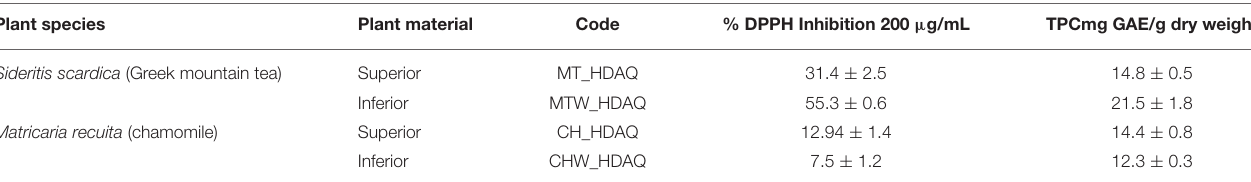
TABLE 7 | The TPC and antioxidant capacity of hydroalcoholic extracts. Plant species Plant